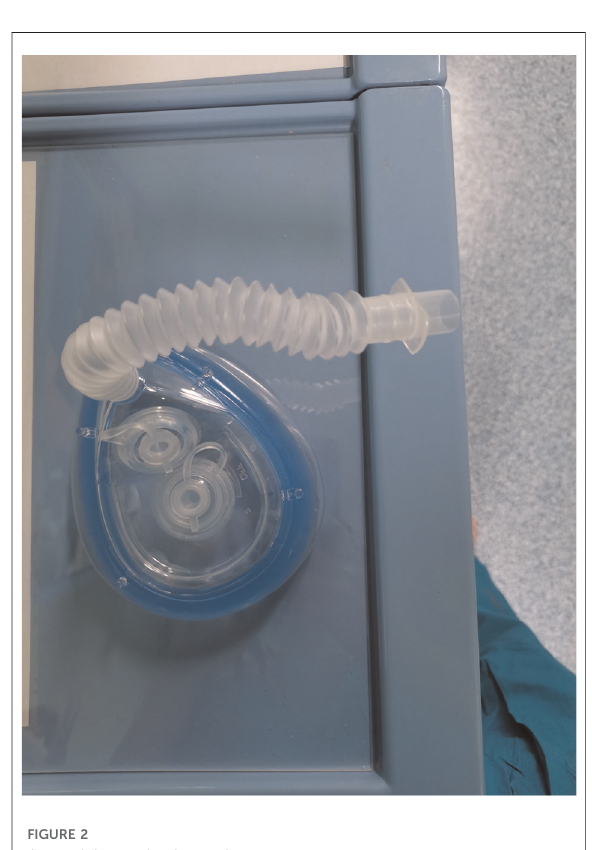
FIGURE 2 A special anesthesia